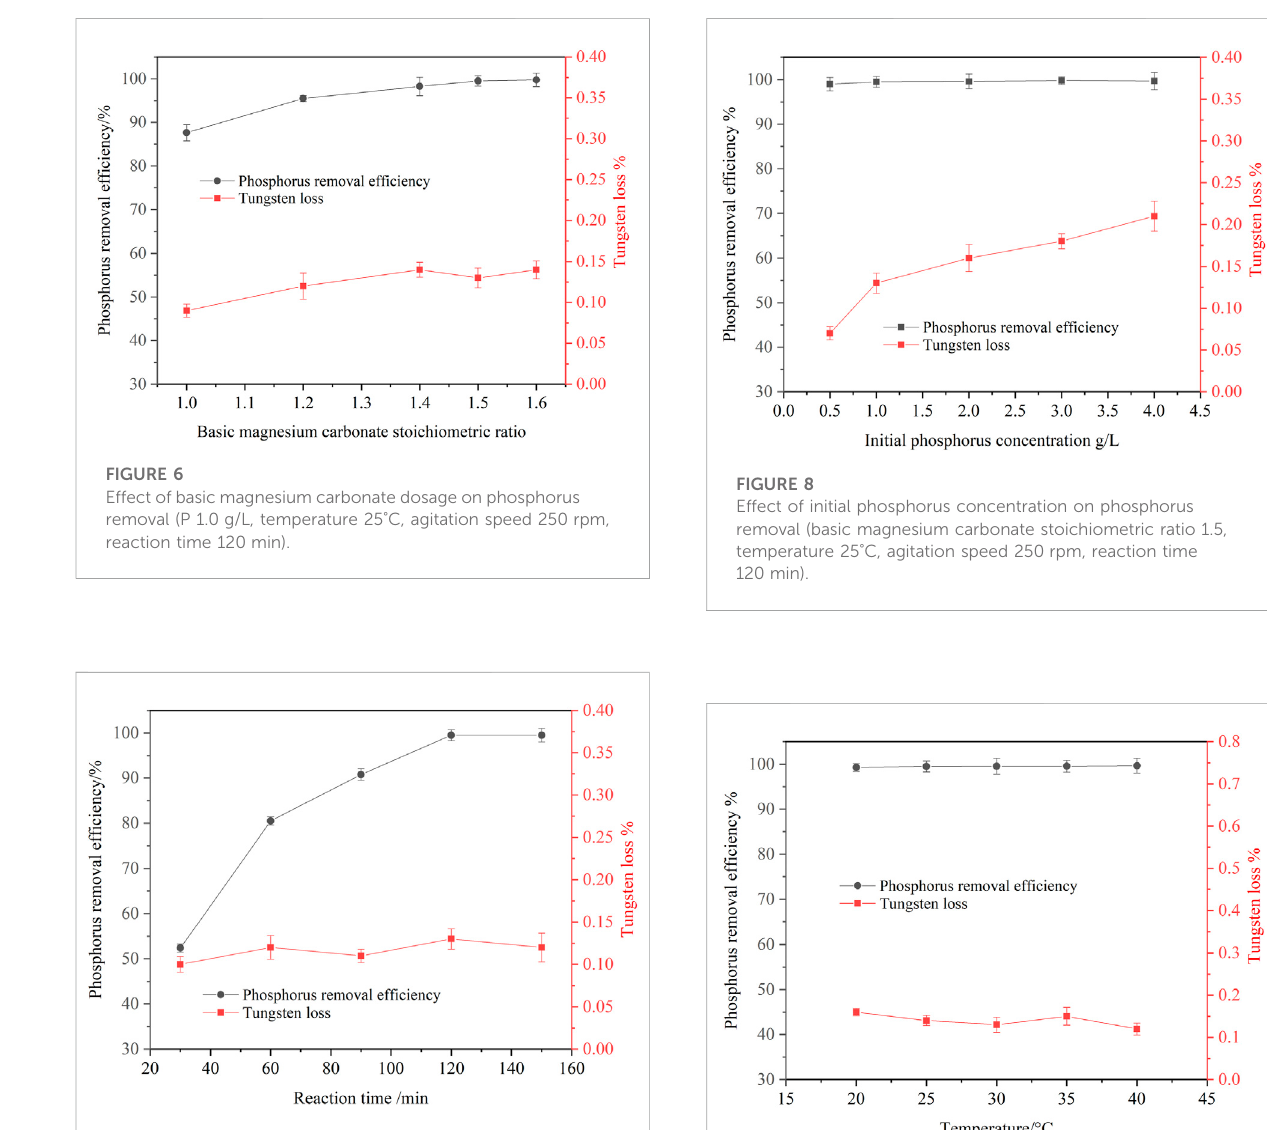
FIGURE 7 Effect of reaction time on phosphorus removal (P 1.0 g/L, basic magnesium carbonate stoichiometric ratio 1.5, temperature 25 ° C, agitation speed 250 rpm).